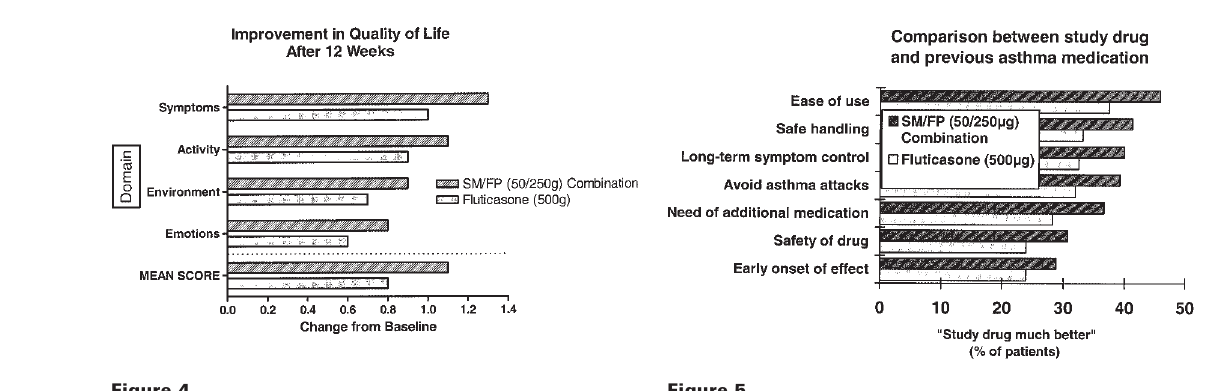
Pulmonary function test results after 6 and 12 weeks of treatment (means and standard devia- tions in parentheses). There were no statis- tically significant dif- ferences between groups, as deter- mined by analysis of co-variance.